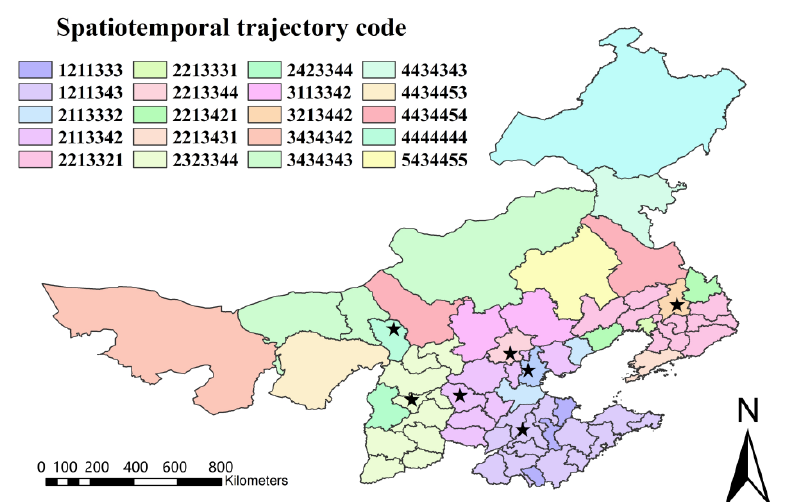
Figure 9. Temporal and spatial changes of prefecture level city scale psychological tolerance in winter 2013–2019. (The stars indicate the capitals of seven provinces).